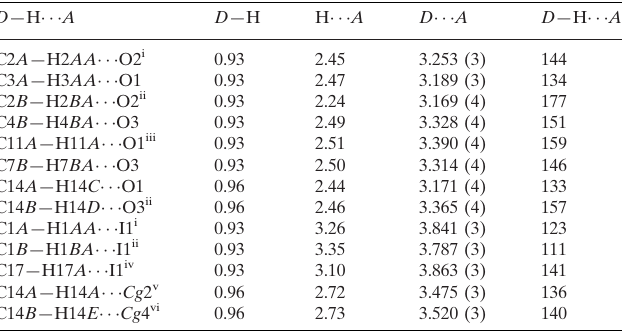
Hydrogen-bond geometry (A˚ , (cid:4) ). Cg 2 and Cg 4 are the centroids of the C8 A –C13 A and C8 B –C13 B phenyl rings,